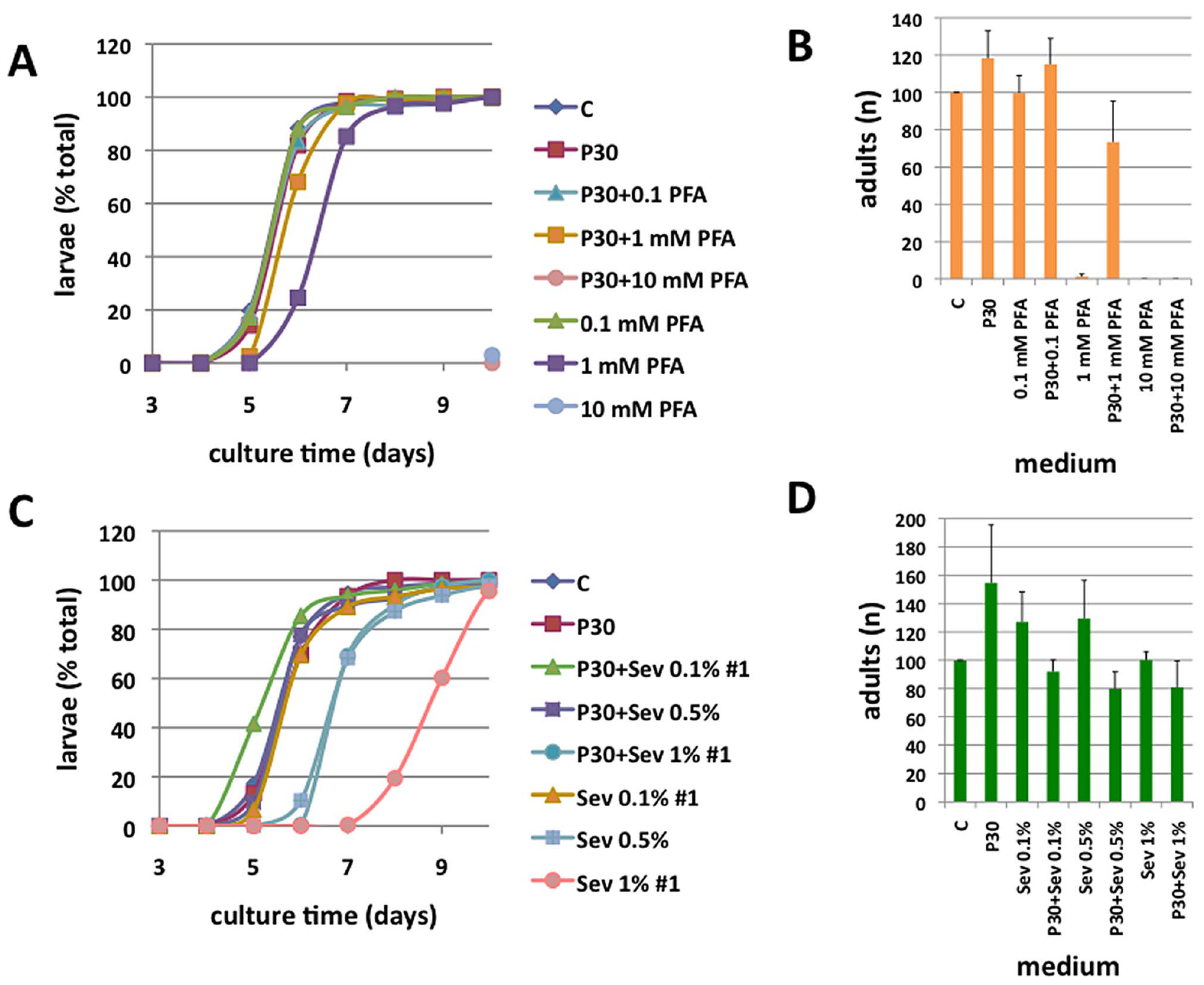
Figure 1. The effect of sevelamer and PFA on larval development is reversible by addition of 30 mM phosphate to the medium. A, C: Number of larvae emerged from the medium. P30=standard medium supplemented with 30 mM sodium phosphate (pH 6.0), PFA=pho- sphonoformic acid 0.1–10 mM, Sev=sevelamer 0.1–1%; Shown are means, CV , 10%, B, D: Number of adults eclosed. Shown are means 6 SEM of one representative experiment, performed in triplicate. da-Gal4 ts . UAS-RNAi animals were examined for larval lethal- ity at 29 u C, the inducing temperature. Adult males were reared at 18 u C to keep the RNAi un-induced during development and used within three days of eclosing for life span assays. Sibling females were used for hemolymph phosphate assays as described above.